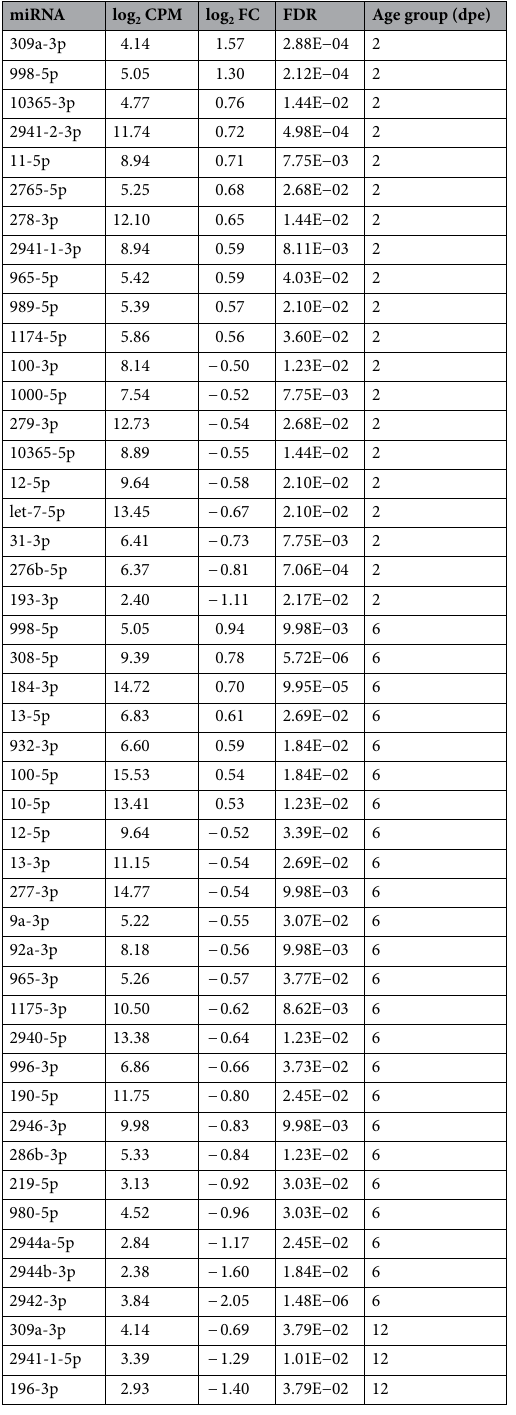
Table 1. Differential expression of 46 miRNAs in WB2 versus WB2.tet mosquitoes in three age groups. Log 2 fold-changes > 0 represent upregulation in WB2 compared to WB2.tet. log 2 CPM, counts per million reads mapped to each miRNA given (log 2 ). FDR, false discovery rate (Benjamini–Hochberg corrected